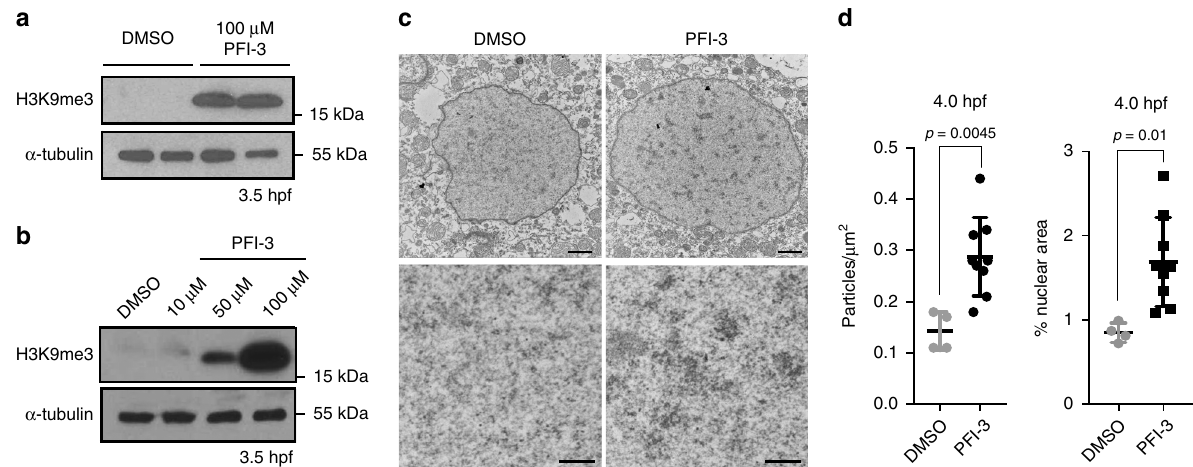
Fig. 6 Smarca2 inhibition accelerates the timeline of chromatin compaction. a Western blot for H3K9me3 (top), and α -tubulin (bottom) in embryos that were either mock injected or injected with 100 μ M of the Smarca2 inhibitor PFI-3 at the one-cell stage. Protein was collected for analysis at 3.5 h post fertilization (hpf). b Western blot using embryos injected with increasing concentrations of PFI-3. Protein was collected for analysis at 3.5 hpf. c Electron micrographs demonstrating increased levels of chromatin compaction in 4.5 hpf embryos that were injected with dimethyl sulfoxide (DMSO) or 100 μ M PFI-3 at the one-cell stage. Bottom panels represent higher magni fi cation images (×20,000) of nuclear interior in mock- and PFI-3-injected embryos at speci fi ed time points. All scale bars indicate 1 μ m. d Quanti fi cation of the number of particles per nuclear μ m 2 and percent nuclear area. Each data point indicates an individual embryo, for each embryo (four DMSO and nine PFI-3-injected embryos) values for particles per um 2 and percent nuclear area were averaged from fi ve to ten representitive nuclei. P values were calculated using the Student ’ s t test; error bars indicate SD. Source data for panels a and b is